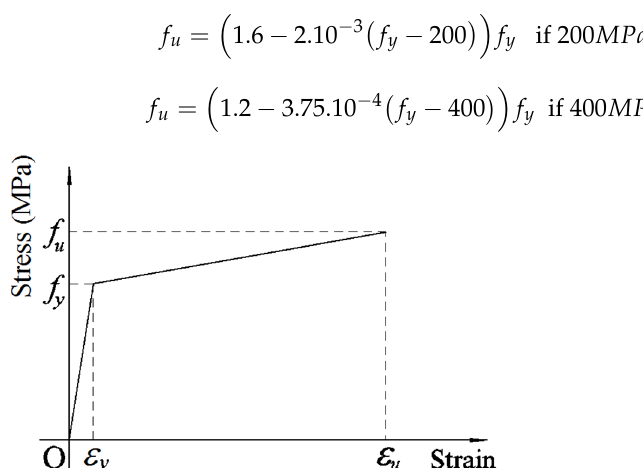
Figure 1. Bilinear stress-strain model of steel.